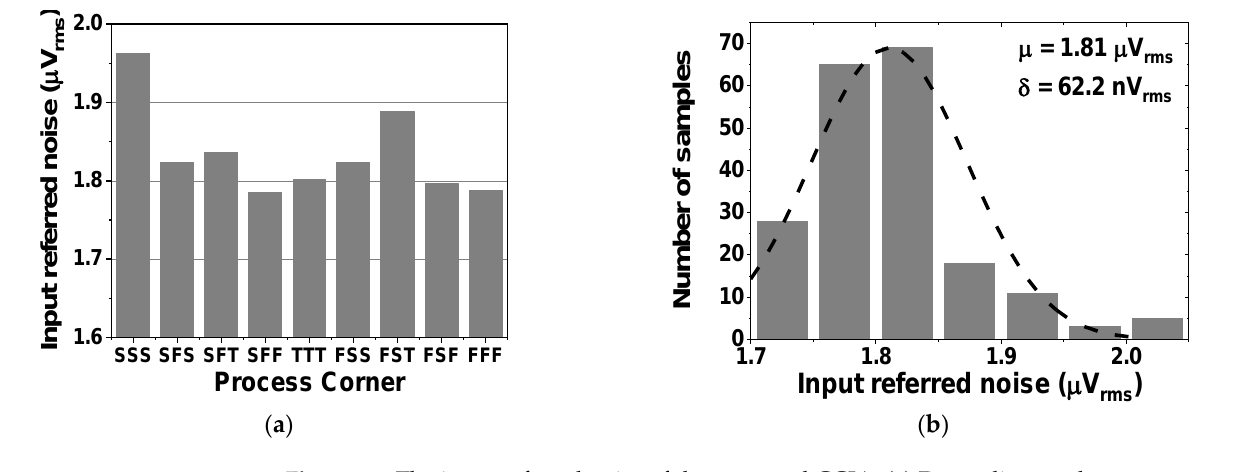
( c ) Figure 11. Monte Carlo simulation results of the mid-band gain of the proposed CCIA for different values of V DD : ( a ) V DD = 1 V, ( b ) V DD = 0.9 V, and ( c ) V DD = 1.1 V.